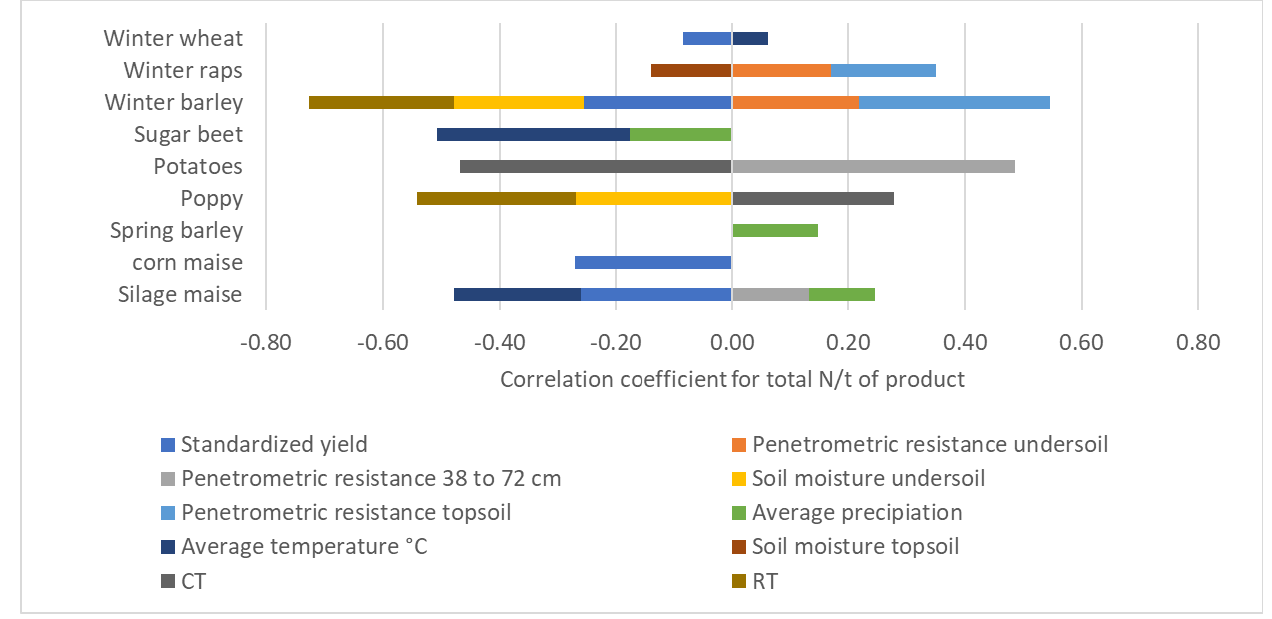
Figure 1. Statistically important correlation coefficients for the production of specific nitrogen consumption per tonne of yield.